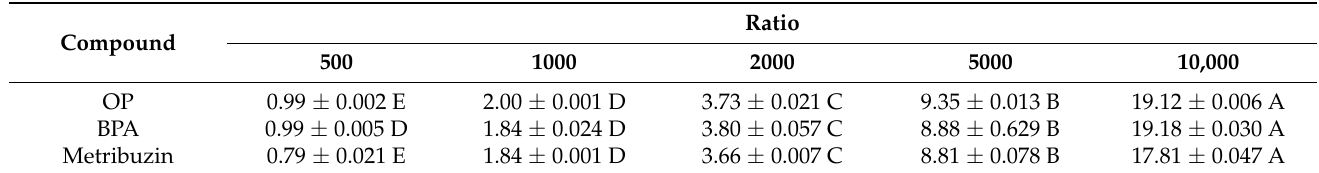
Table 3. Amount of compound adsorbed (mg g − 1 ) as a function of the solution/biochar ratio adopted. One-way analysis of variance (ANOVA) and Duncan’s new multiple range test at p ≤ 0.01 (n = 3) were used for statistical treatment of data.